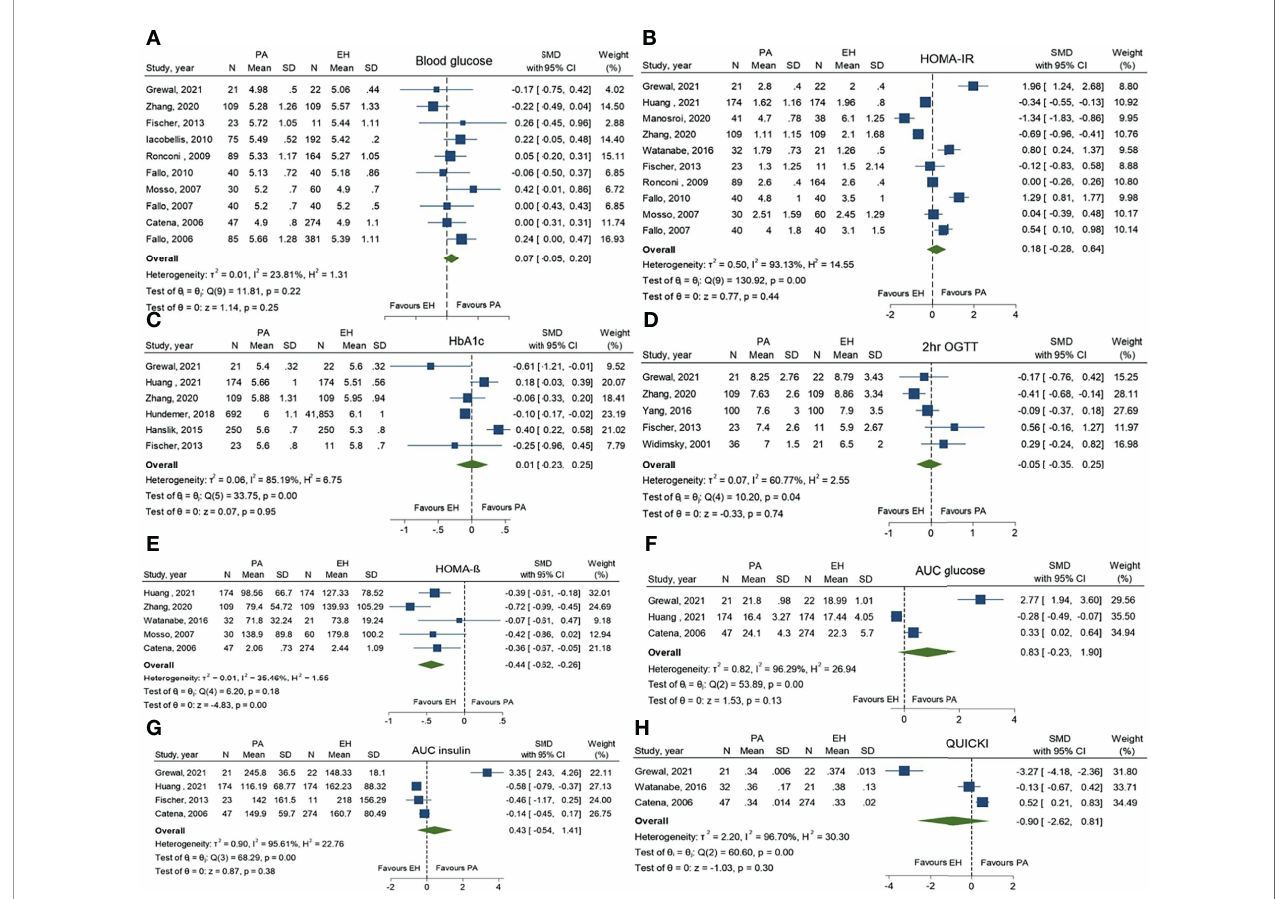
FIGURE 3 | Forest plots comparing glucose metabolic pro fi les of primary aldosteronism and essential hypertension patients: fasting blood glucose (A) , homeostatic model assessment of insulin resistance (HOMA-IR) (B) , HbA1c (C) , 2-hr oral glucose tolerance test (2-hr OGTT) (D) , homeostatic model assessment of ß-cell function (HOMA-ß) (E) , area under the curve (AUC) of glucose (F) , AUC of insulin (G) and the quantitative insulin-sensitivity check index (QUICKI) (H)